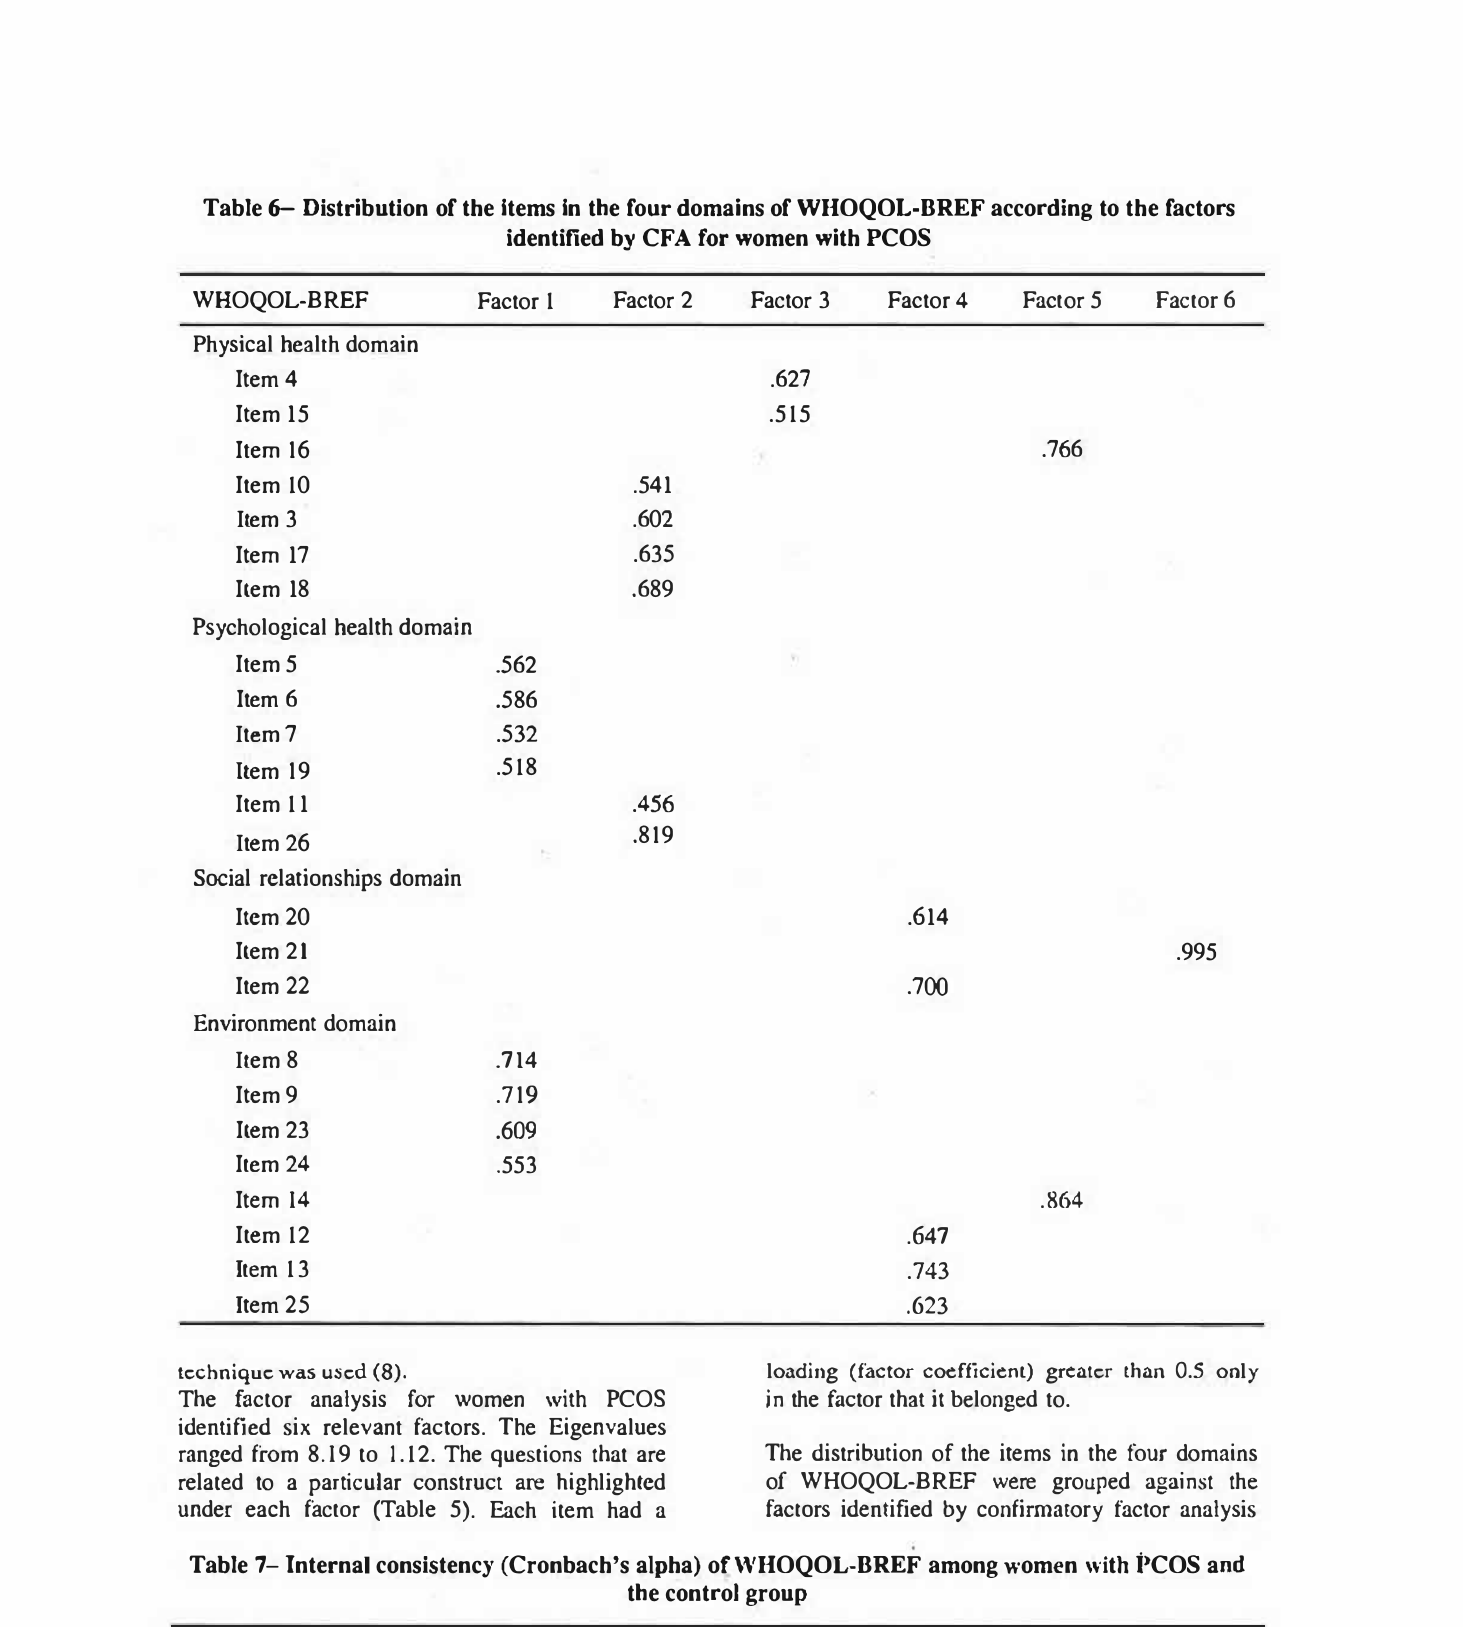
Table 7-Internal consistency (Cronbach's alpha) of. WHOQOL-BREF among women with i>COS